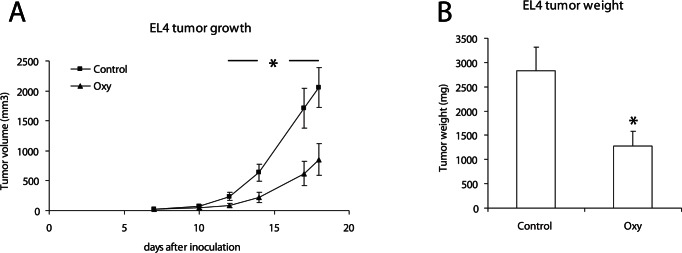
OX inhibits EL4 lymphoma growth in vivo.A: Anti-tumor effect of OX in EL4 tumors inoculated (s.c.) into wild type mice. OX was administrated p.o. at 30 mg/kg/day 7 days/week from day 1 throughout the experiment. Each data point represents mean ± SEM (n = 10; *p<0.05, Mann Whitney U). Control animals received only water. B: Tumor weights (*p<0.05; Mann Whitney U).